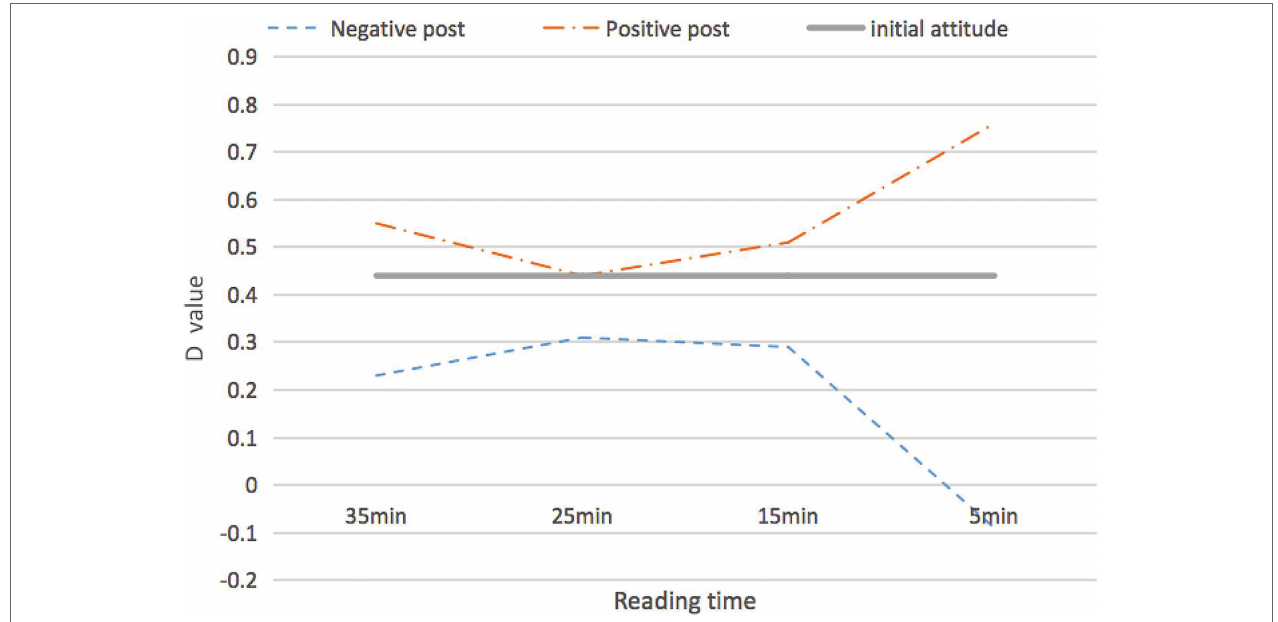
FIGURE 1 | D-values of Single Category Implicit Attitude Test (SC-IAT) under different reading